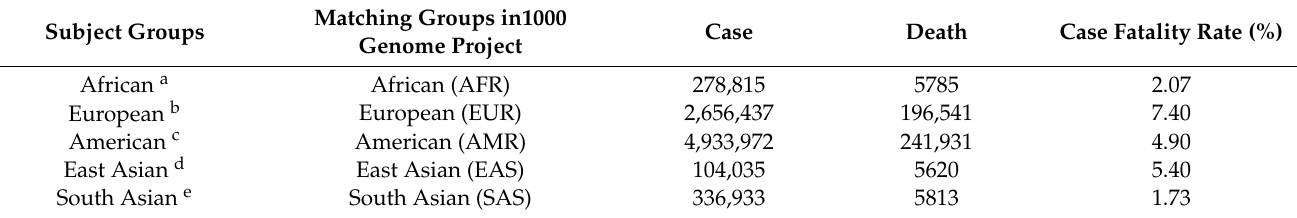
Table 1. Information on cases and deaths of coronavirus disease 2019 (COVID-19) in several ethnic groups (29 June, 2020).